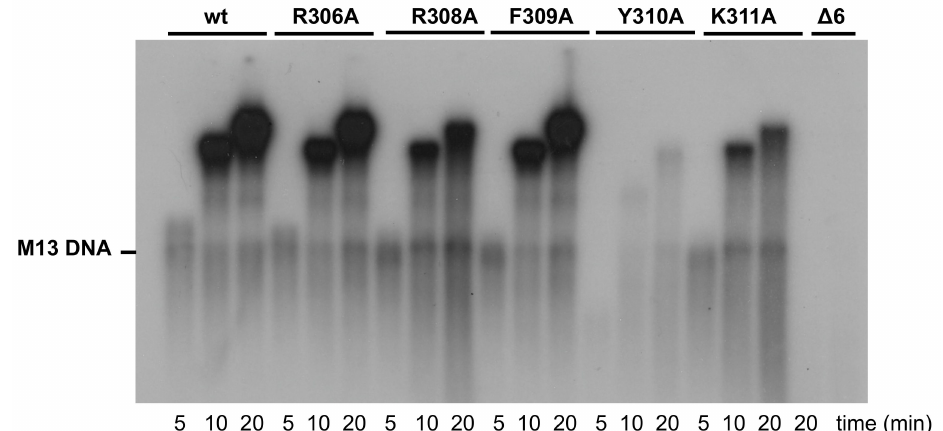
Figure 5. Strand-displacement coupled to M13 DNA replication by wild-type and mutant DNA polymerases. Replication of primed-M13 DNA was carried out as described in Materials and Methods. After incubation for the indicated times at 30 ◦ C, relative activity values were calculated from dNMP incorporation. The position of unit-length M13 DNA is shown on the left.